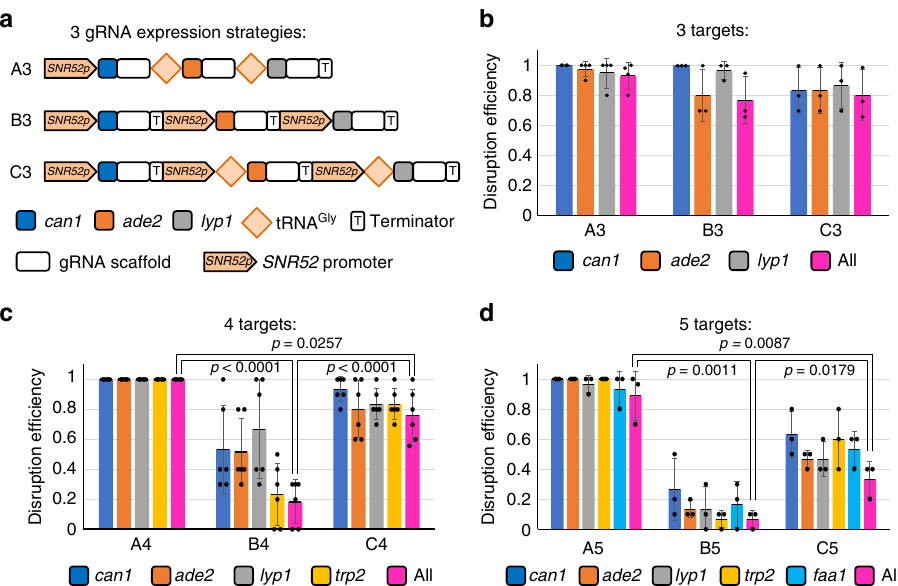
Fig. 2 Evaluations of different guide RNA (gRNA) expression systems for 3 – 5 genes. a Graphic representation of the three different gRNA expression systems for three-gene disruptions. The A3, B3, and C3 represent three gRNAs expressed from mode A, B, and C, respectively. b – d Results of disruption ef fi ciencies of 3 – 5 genes. The data of bar charts represent mean averages of each gene or overall disruption ef fi ciencies. Each black dot represents the gene disruption ef fi ciency of 10 colonies from each biological replicate, and the error bars indicate the standard deviations of all ( n ≥ 3) biological replicates. The statistical analyses were performed using unpaired t Test. Source data are provided as a Source Data fi